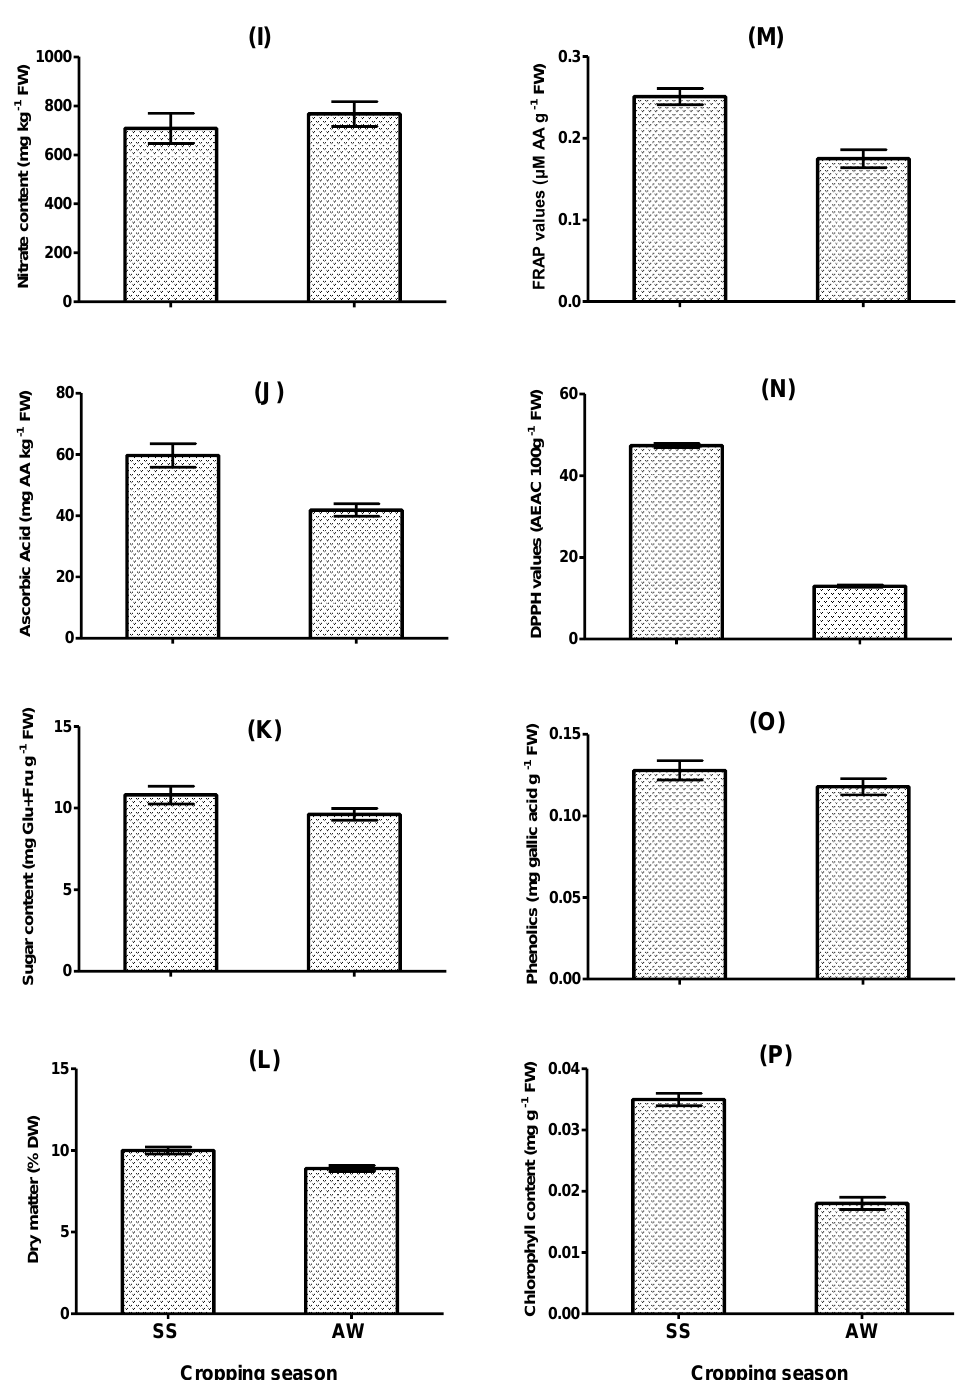
Figure 3. Evaluation of growth (( A ) pod yield and ( B , C ) biomass production), ( D ) chlorophyll fluorescence, gas exchange parameters (( E ) net CO 2 assimilation rate, ( F ) stomatal conductance, ( G ) intercellular CO 2 concentration and ( H ) transpiration), pod nutritional quality (( I ) nitrate content, ( J ) ascorbic acid, ( K ) total sugars, ( L ) dry matter, antioxidant ( M ) FRAP and ( N ) DPPH values, ( O ) phenolics and ( P ) chlorophyll content) in two cropping seasons (spring-summer, SS crop; autumn-winter, AW crop) of hydroponic common bean. Values are means calculated across treatments and vertical bars indicate ± standard errors of means.